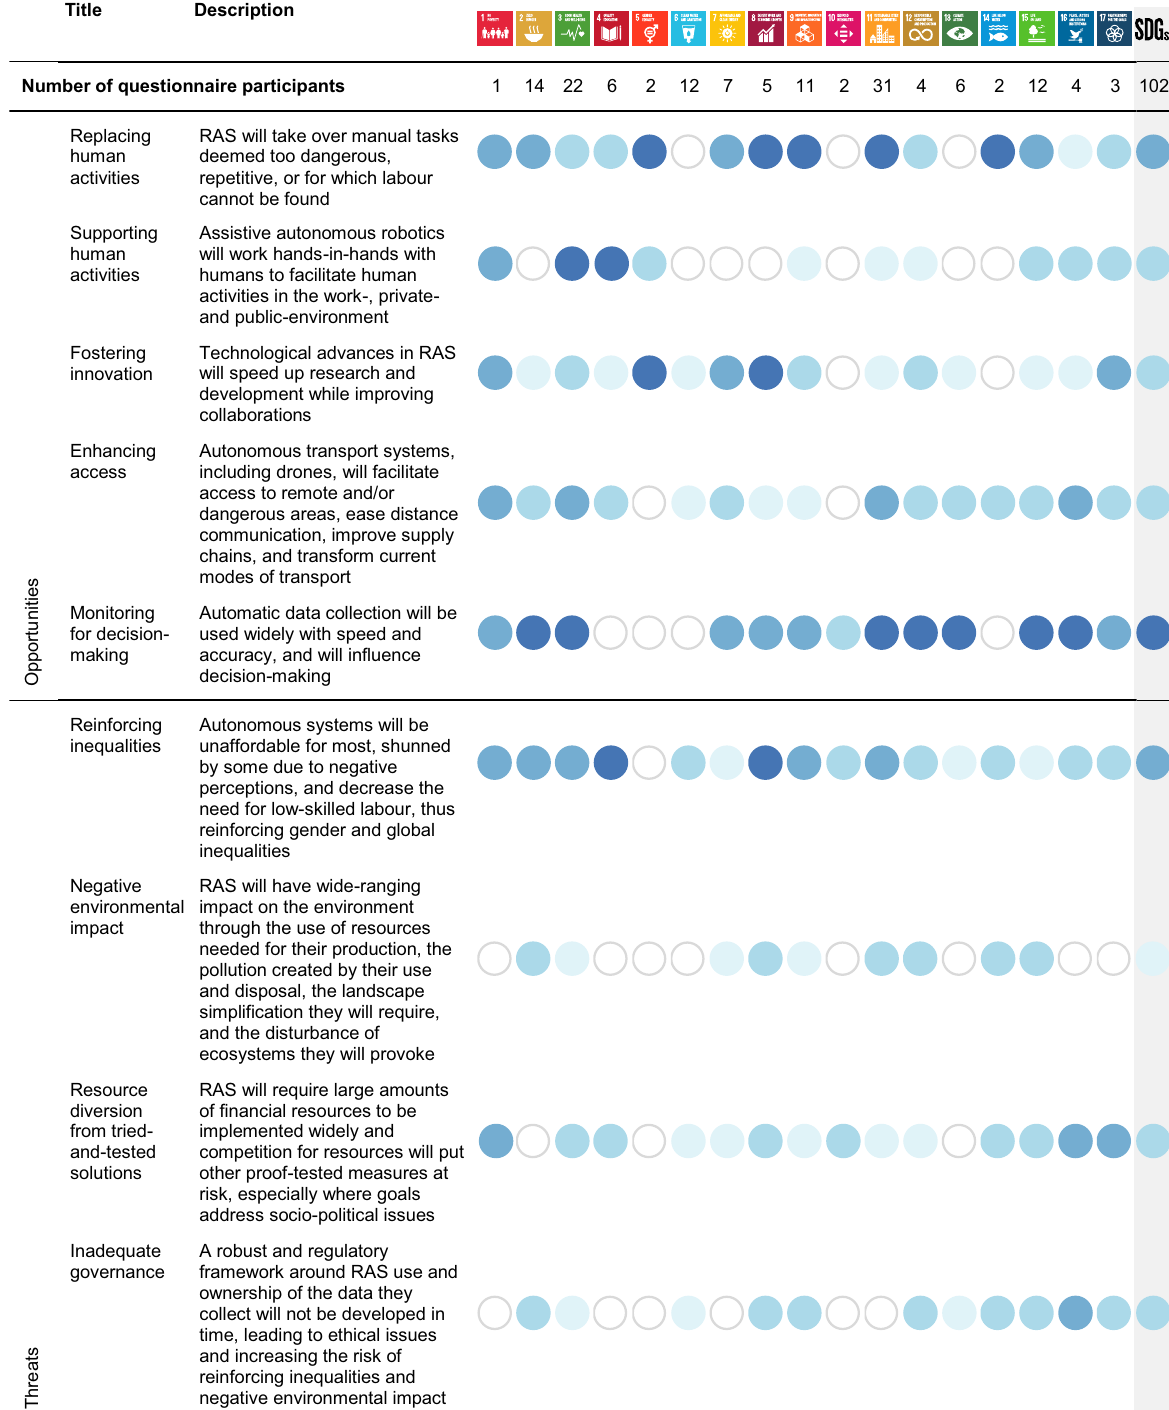
Fig. 3 Description of each opportunity and threat, with proportion of questionnaire participants identifying each, highlighting the level to which each opportunity or threat is considered relevant for the Sustainable Development Goal (SDG). See Fig. 1 and https://www.un.org/sustainabledevelopment/ for SDG icon de fi nitions and further information. The content of this publication has not been approved by the United Nations and does not re fl ect the views of the United Nations or its of fi cials or Member